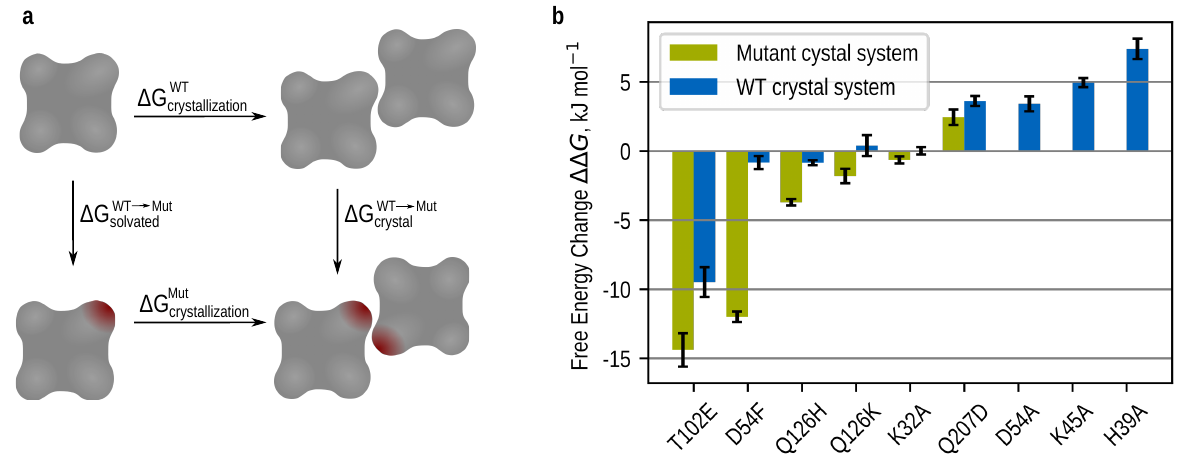
Figure 3. Free energy difference calculation. ( a ) Thermodynamic cycle for crystallization of wild type and mutant protein. A negative free energy difference between mutant (Mut) ∆ G Mut and wild type (WT) ∆ G WT crystallization crystallization − ∆ G WT ) denotes a thermodynamic favor of mutant over wild type crystal- crystallization ( ∆∆ G = ∆ G Mut crystallization crystallization lization. As both values are not accessible by simulation, we calculate the numerically equivalent free energy difference as ∆∆ G = ∆ G WT → Mut − ∆ G WT → Mut . Both individual values are accessible in free energy simulations in which the solvated crystal solvated unbound wild type is alchemically transformed into solvated mutant protein ( ∆ G WT → Mut ) and the crystal bound wild solvated type into crystal bound mutant protein ( ∆ G WT → Mut ) (see Supporting Information Section S5 for more details). ( b ) Free crystal energy change ∆∆ G for wild type vs. mutant crystallization. Green and blue bars indicate calculation in mutant and wild type crystal packing,